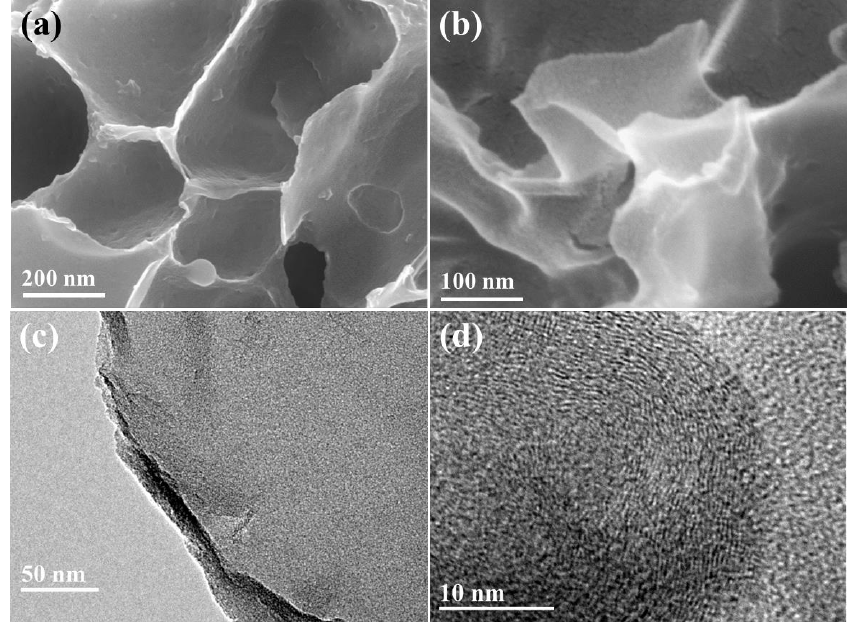
Figure 2. SEM ( a – c ) and TEM ( d ) images of the activated lotus leaf at 800 °C for 1 h with 100 mL min −1 of N 2 .